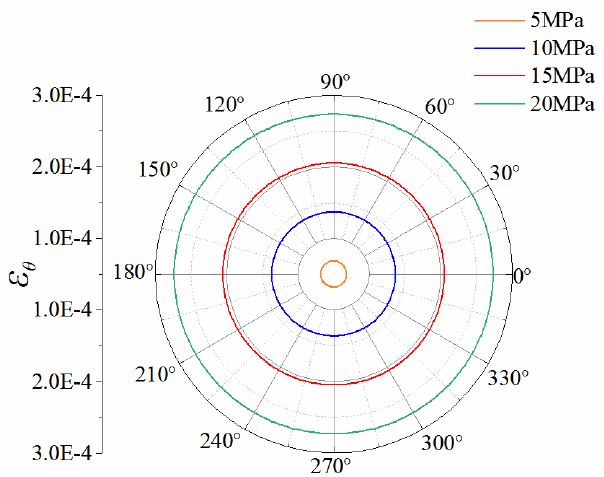
of radial cracks.